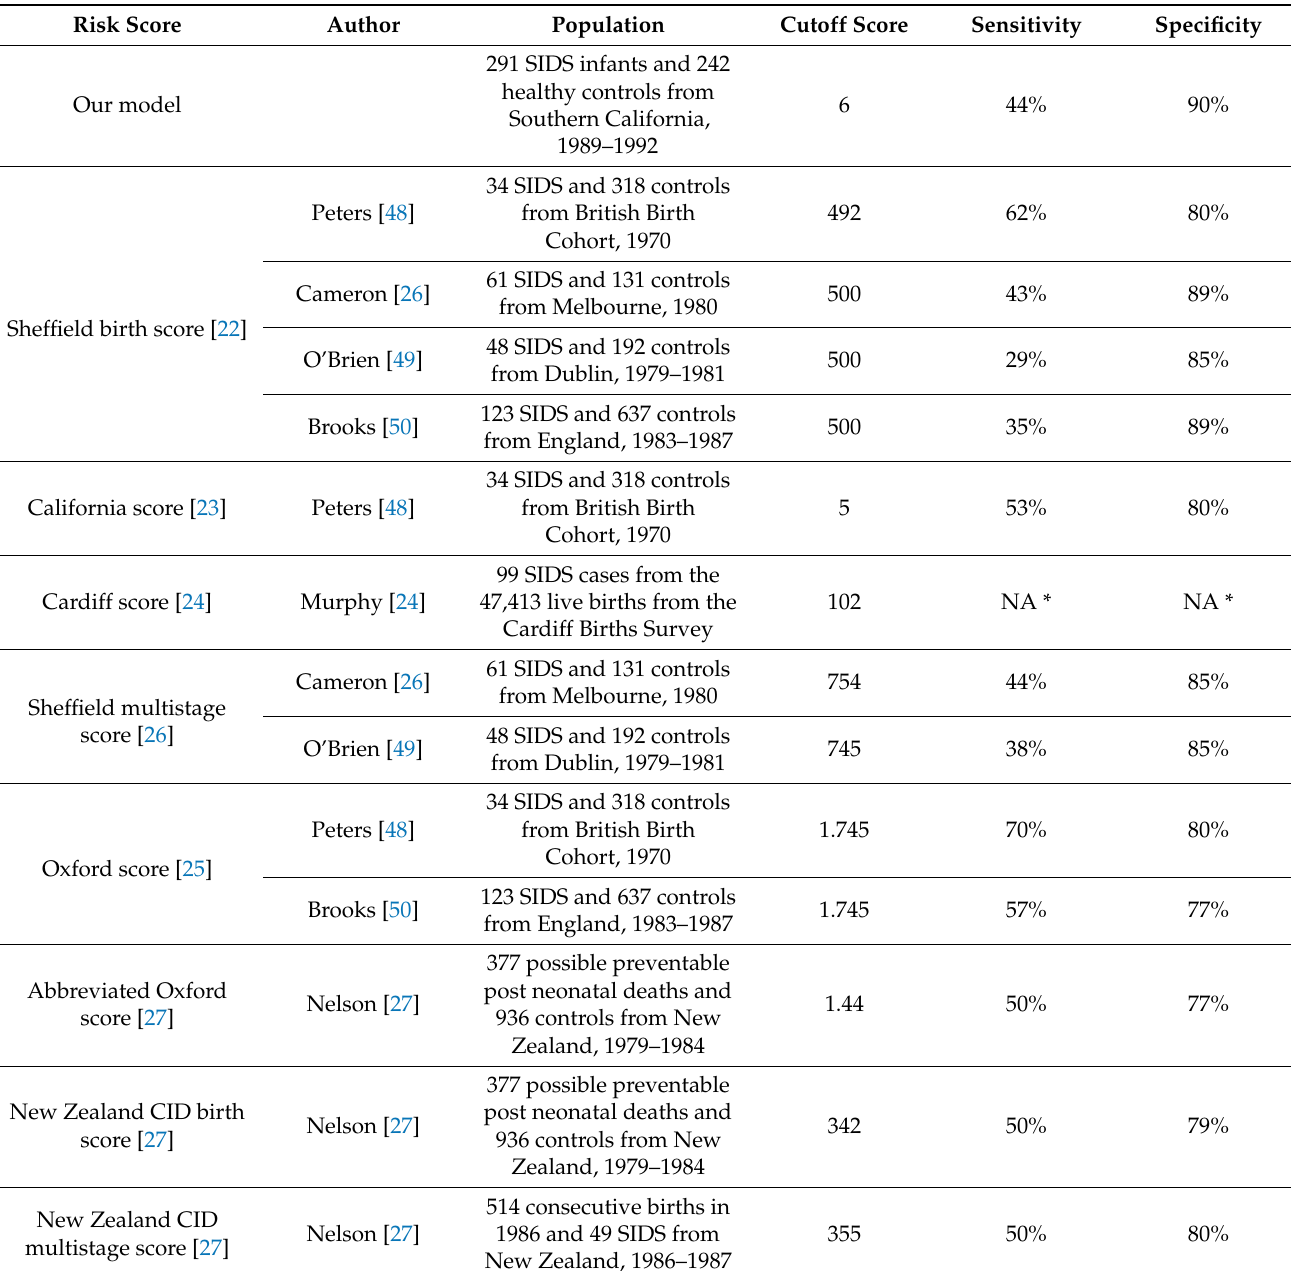
Table 5. Performance of Our Risk Score Compared to Existing Risk